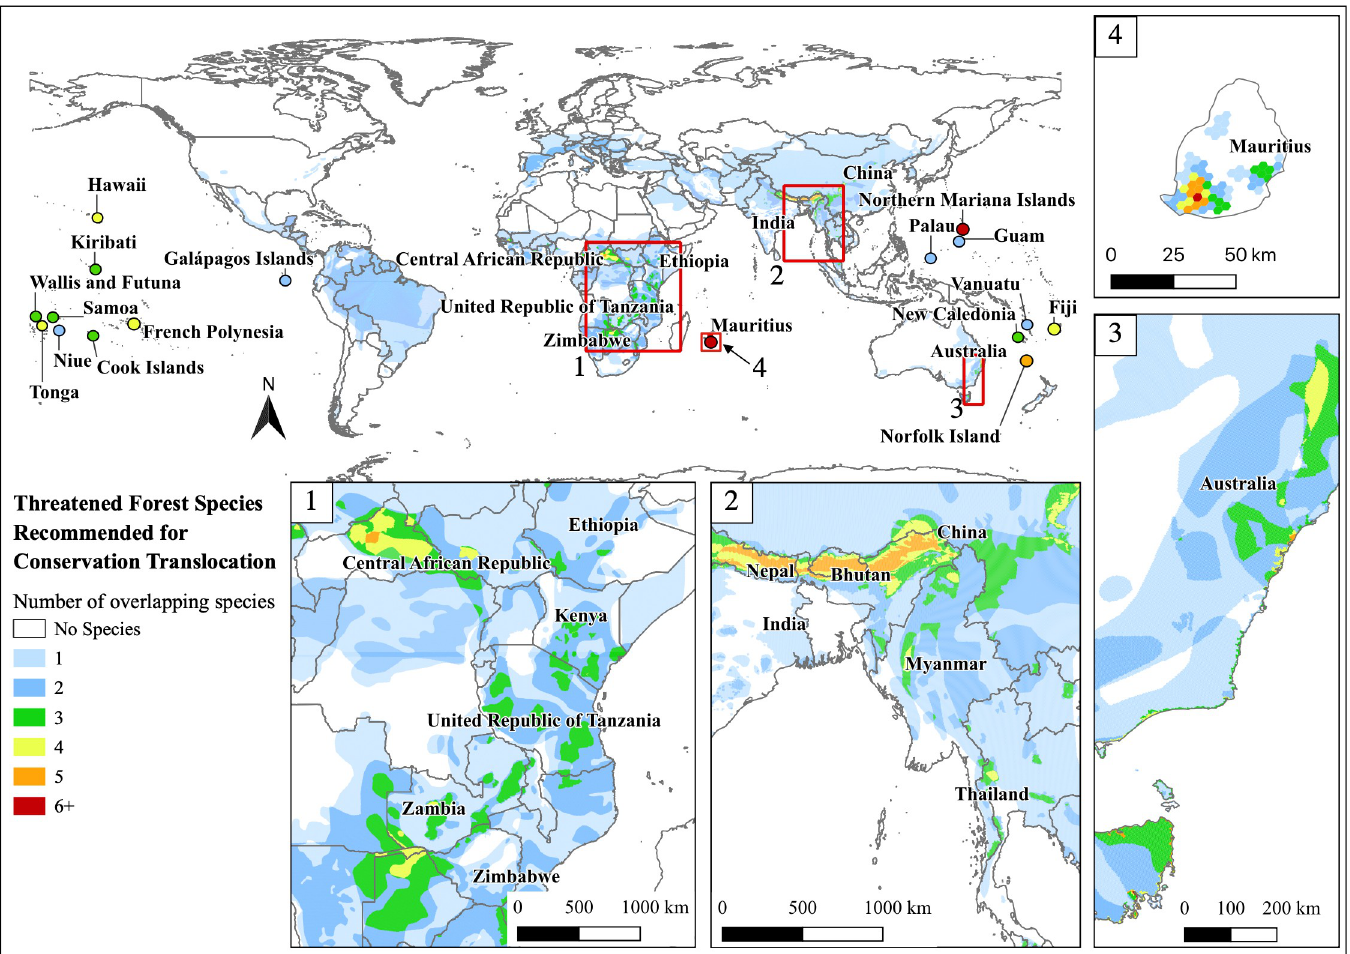
Fig 1. Overlapping species’ range maps for 152 threatened and Near Threatened terrestrial species, amphibians, birds, mammals, that live in forest habitat with CT as a recommended conservation action. Reprinted partially from the Environmental Systems Research Institute (ESRI) under a CC BY license, with permission from ESRI, original copyright